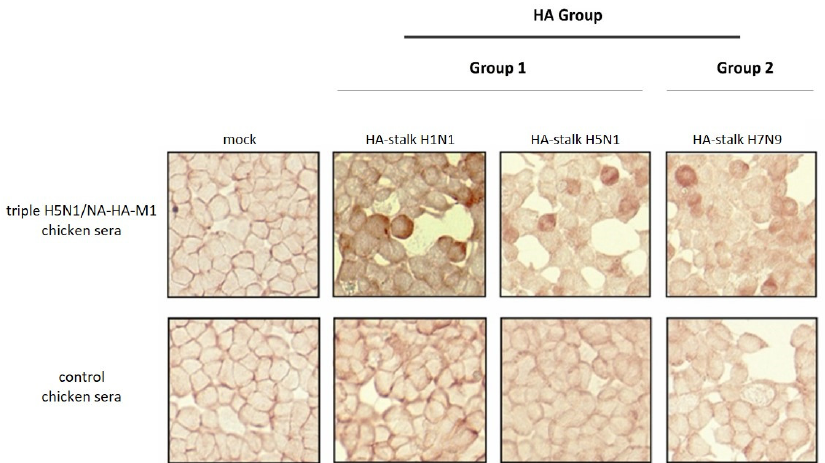
Figure 9. Cross-reactivity of chicken sera obtained after vaccination with triple H5N1/NA-HA-M1 VLPs with the HA-stalk antigens from the 1 and 2 HA groups. Detection of HA-stalk from H1N1, H5N1 and H7N9 strains was performed on transfected HEK293 cells. Sera from unvaccinated hens were used as a background. Non-transfected cells were used as a negative control. Images were taken at ×40 magnification.